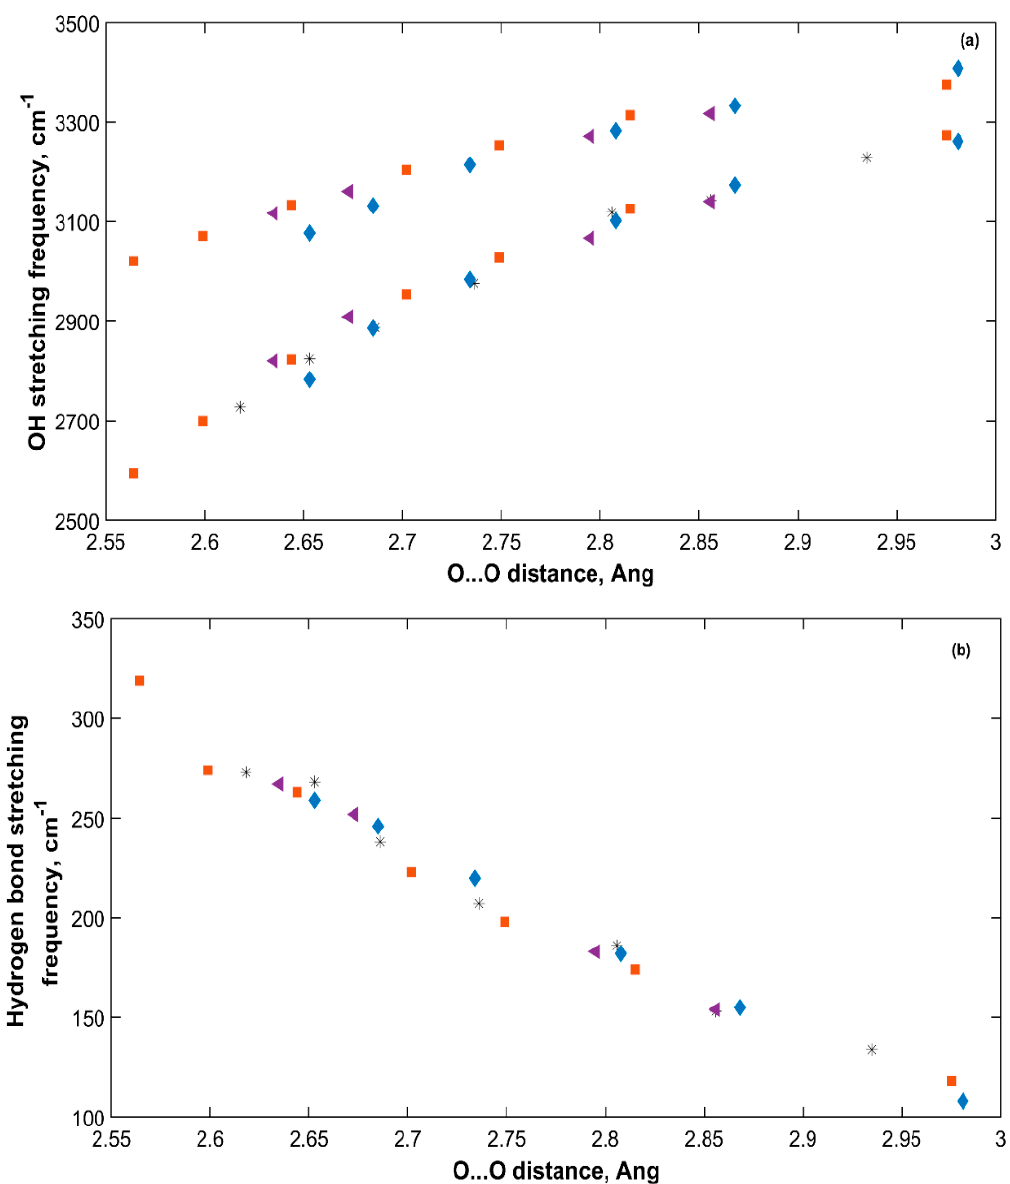
Figure 9. OH ( a ) and hydrogen bond ( b ) stretching frequencies of all sH hydrates versus O···O distance. Empty ( ■ ), Xe-NH ( * ), CO 2 -NH ( ♦ ), CO 2 -CH 4 -NH ( ◄ ).